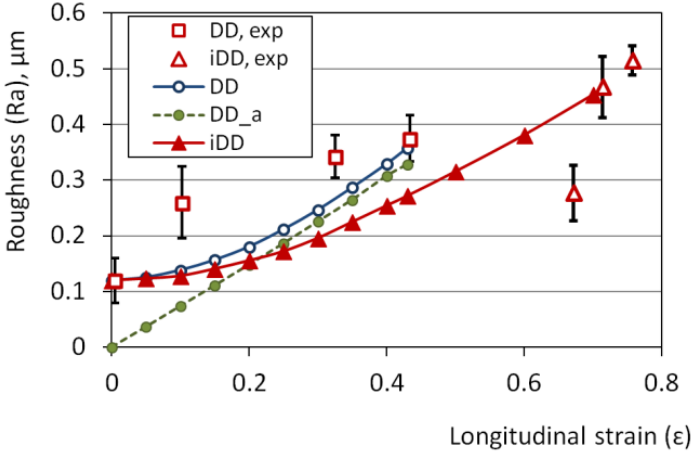
Figure 7. Results of experimental and numerical study of the strain effect on roughening for incre- mental dieless drawing (IDD) and conventional dieless drawing (CDD). In the figure, calculated and experimental (exp.) data for CDD and IDD are shown. The initial roughness Ra was equal to 0.12 µm (IDD and CDD) and 0 µm (CDD (a)).